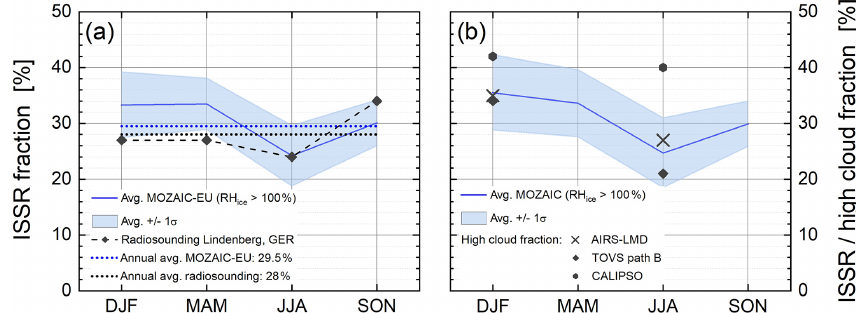
Figure 13. (a) Seasonal cycle of ISSR occurrence probability, i.e. p(RH ice > 100%), averaged over Europe for the years 1995 to 2010 for the two UT layers positioned closest to the thermal tropopause. The symbols represent the annual cycle of the Lindenberg sounding (2000–2001) from Spichtinger et al. (2003a). (b) seasonal cycle of ISSR occurrence probability, as p (RH ice > 100%), averaged over the northern mid- latitudes from eastern North America to Europe for the period 1995 to 2010. The symbols represent high cloud fractions from the satellite cloud climatology by Stubenrauch et al. (2010) for northern mid-latitudes and the years 2003 to 2008 for AIRS-LMD (Atmospheric Infrared Sounder analysed at the Laboratoire de Météorologie Dynamique in Paris), 1987 to 1995 for TOVS-Path B (TIROS-N Operational Vertical Sounder Path-B cloud retrieval) and 2006 to 2007 for